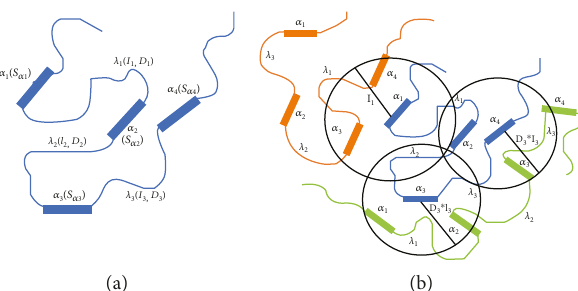
Figure 1: Schematic representation of the model system with one (a) and three interacting molecules (b). s α i is the binding preference of a binding element ( α ), which is computed as the average of the residue-based binding a ffi nities (equation (1)). D i is the dynamics of the linker ( λ ) with length l i , which is obtained as the average of the residue-based values (equation (5)). The local concentration of the , which is scaled by the linker dynamics ( D i , equation available binding sites is computed within a volume V l i